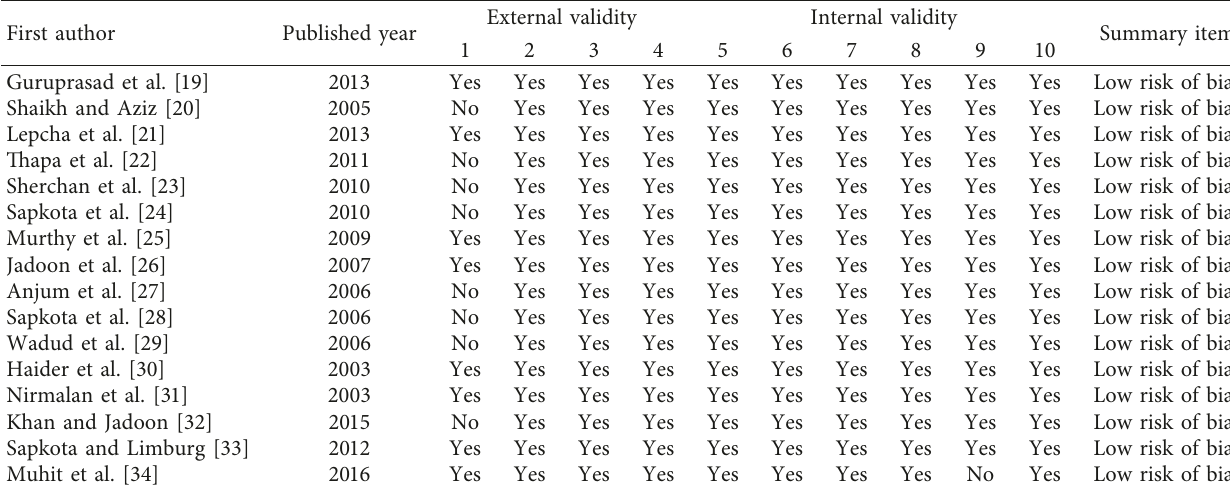
Table 2: Risk of bias of individual